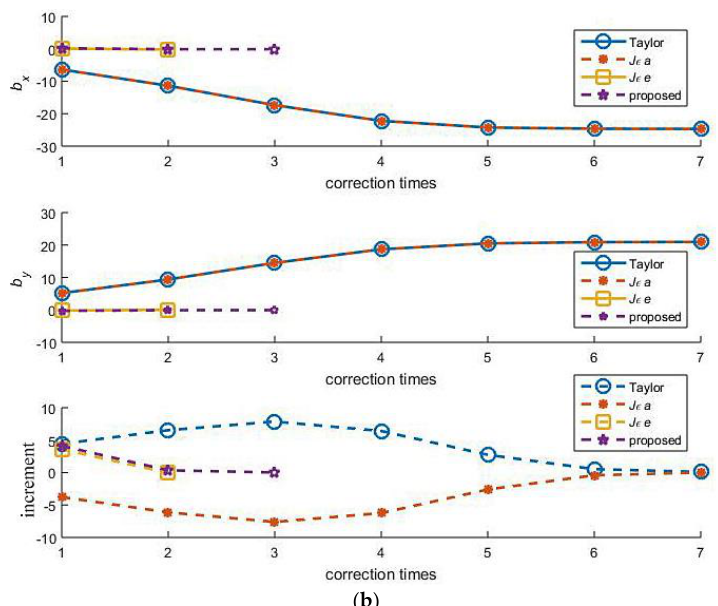
Figure 10. The biases to the true value and the increment to the initial value after each correction in the convergence process. ( a ) R 10 = -0.043 m, R 20 = −2.490 m, R 30 = −2.433 m, p = (−2, 0) T , σ = 0.03 m, ( b ) convergence process. ( a ) R 10 = − 0.043 m, R 20 = − 2.490 m, R 30 = − 2.433 m, p = ( − 2, 0) T , σ = 0.03 m, R 10 = 1.263 m, R 20 = −0.226 m, R 30 = −1.712 m, p = (−1, 1) T , σ = 0.1 m. ( b ) R 10 = 1.263 m, R 20 = − 0.226 m, R 30 = − 1.712 m, p = ( − 1, 1) T , σ = 0.1 m.